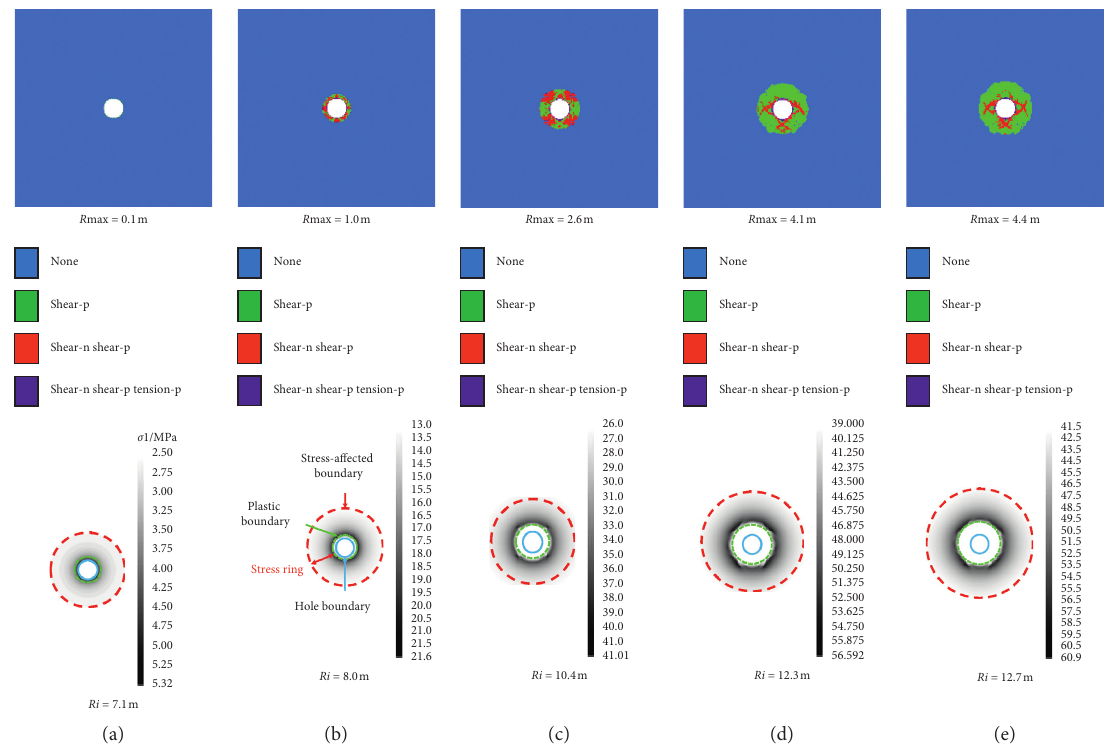
Figure 2: Plastic area of the surrounding rock of hole in coal body and its influence range: (a) H � 100m; (b) H � 500m; (c) H � 1000m; (d) H � 1500m; (e) H �